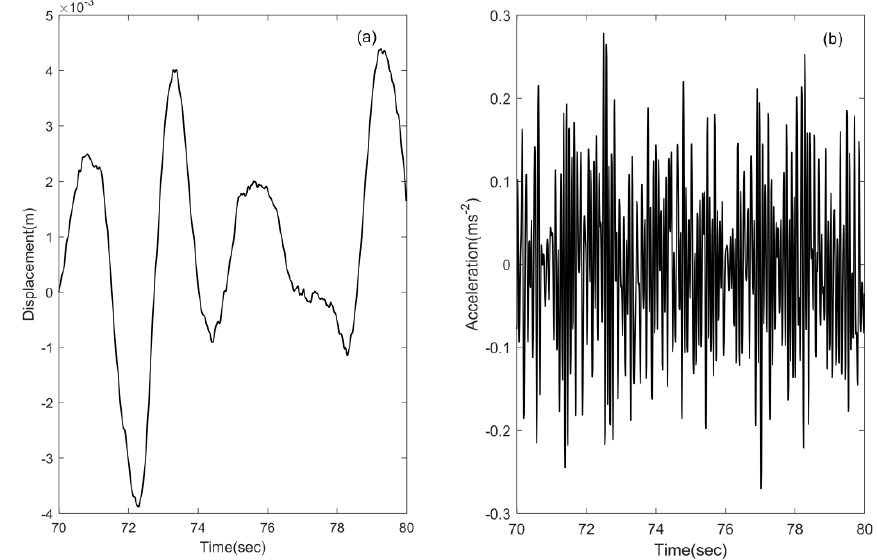
Figure 4. The displacement and acceleration responses ( a , b ), and ( c ) control forces (12) of the hybrid isolator with QZS for case (i).